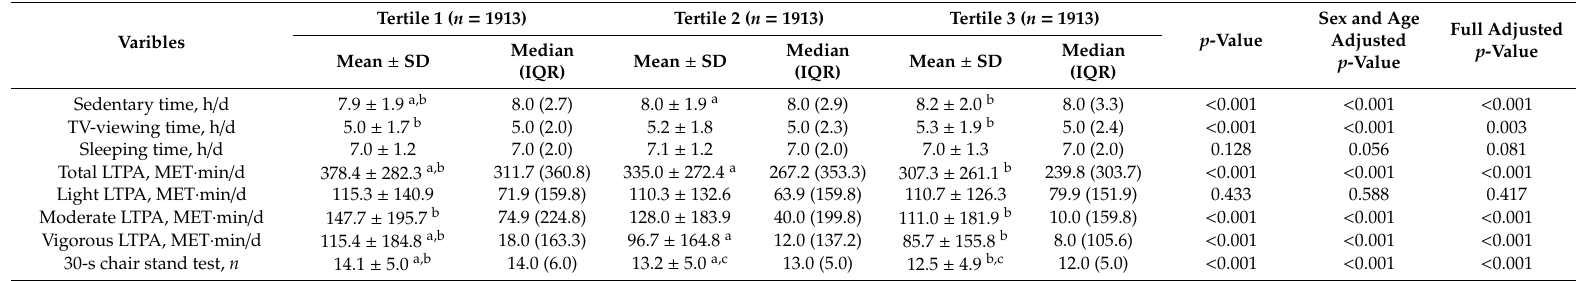
Table 3. Physical activity parameters and sedentary behaviour according to tertiles of MetS Severity Score.